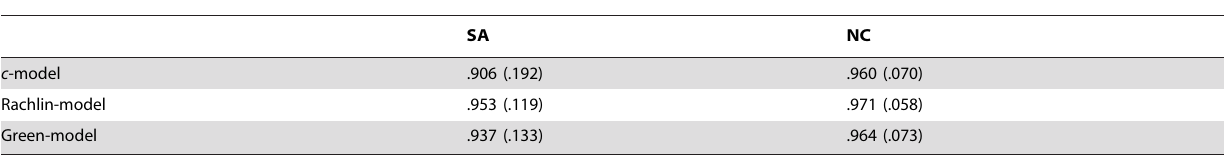
Table 4. Median R 2 Within SA and NC.